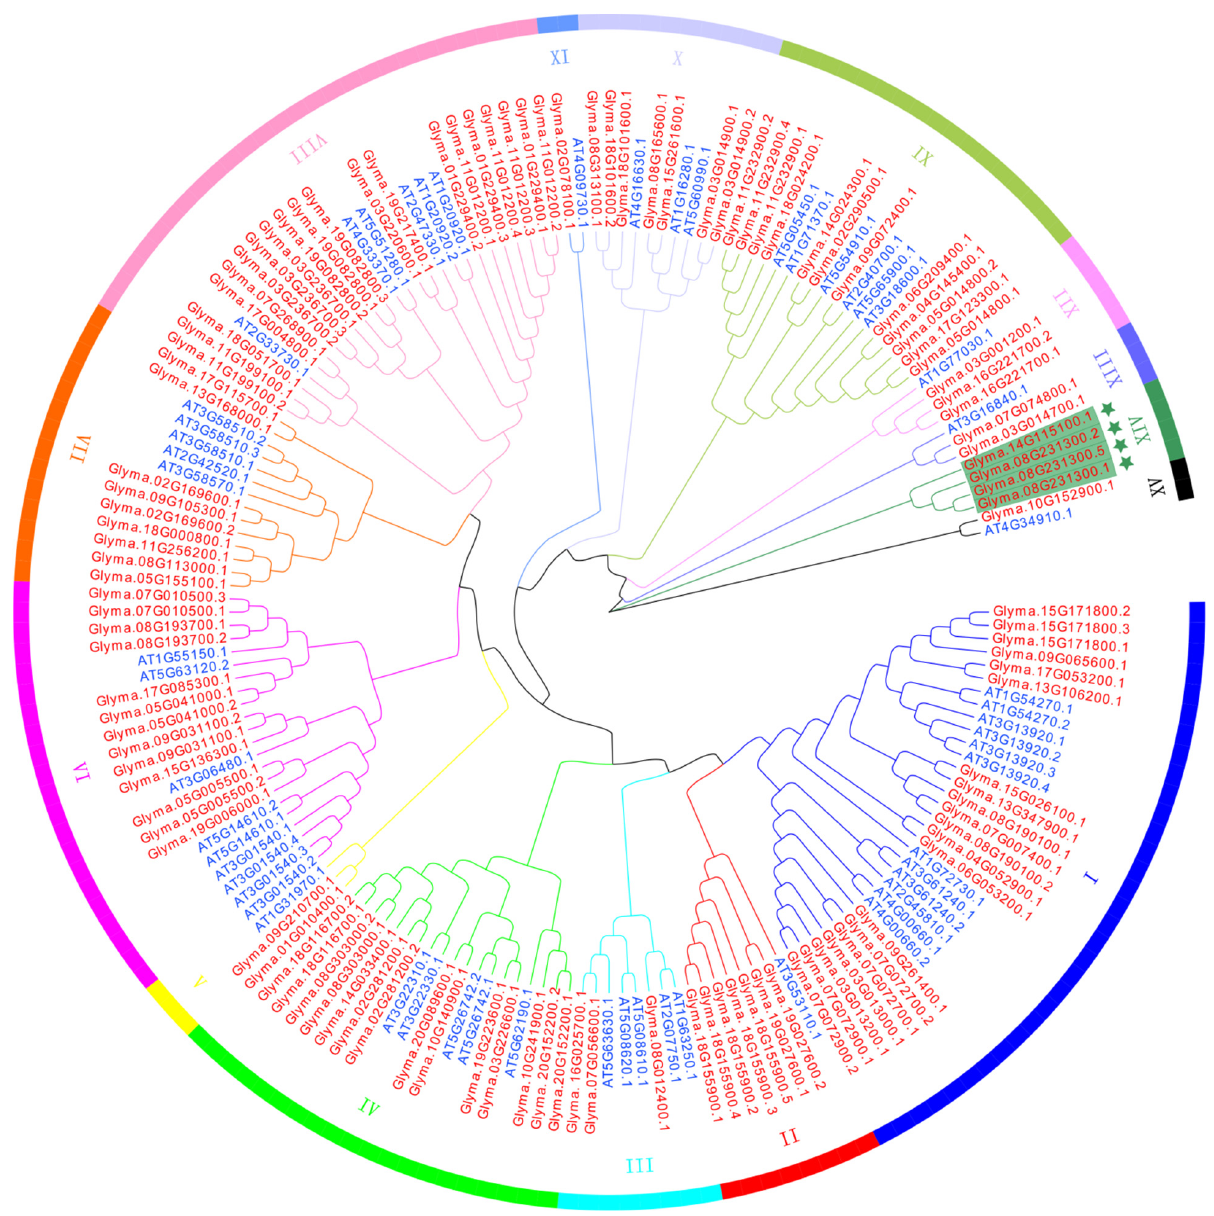
Figure 2. Phylogenetic tree of DDX proteins in Arabidopsis thaliana and soybean. Tree constructed with 1000 bootstrap replications. DDX proteins from Arabidopsis and soybean distinguished using blue and red, respectively. Proteins from different clusters (I–XV) were indicated with different color zones. Green stars at XIV indicate the soybean-specific DDX